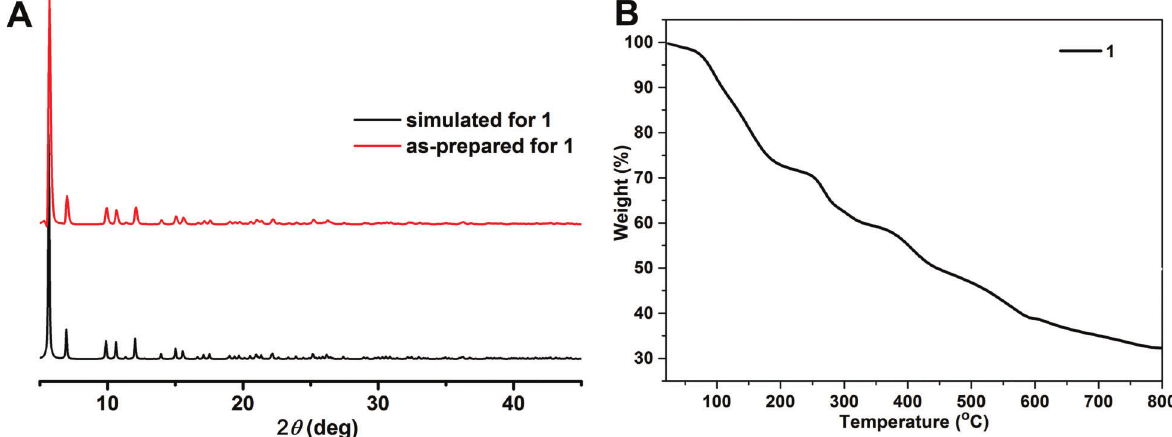
Figure 3. A , powder X-ray diffraction analysis patterns for compound 1 . B , TGA curve for 1 .